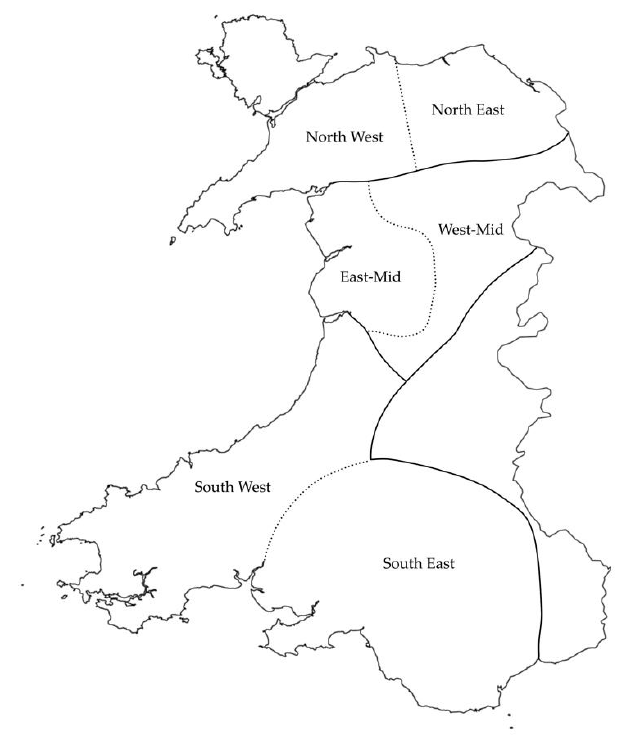
Figure 1. Main dialect areas of Wales (adapted from Thomas and Thomas [16] (p. 28)).